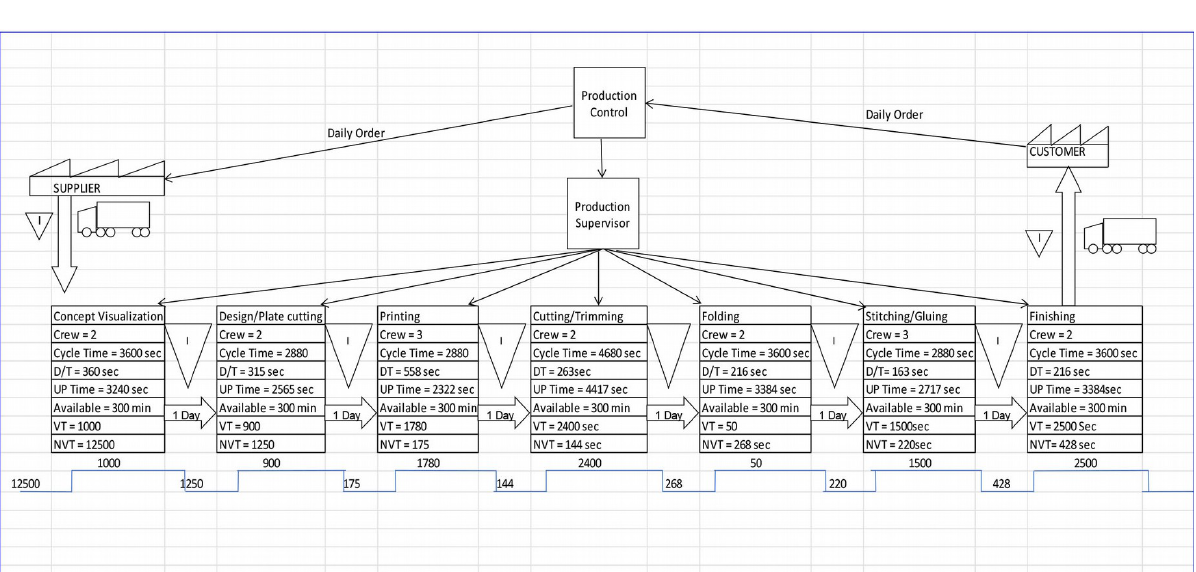
Table 7. Future Value Added and Non-Value-Added Time of the production line